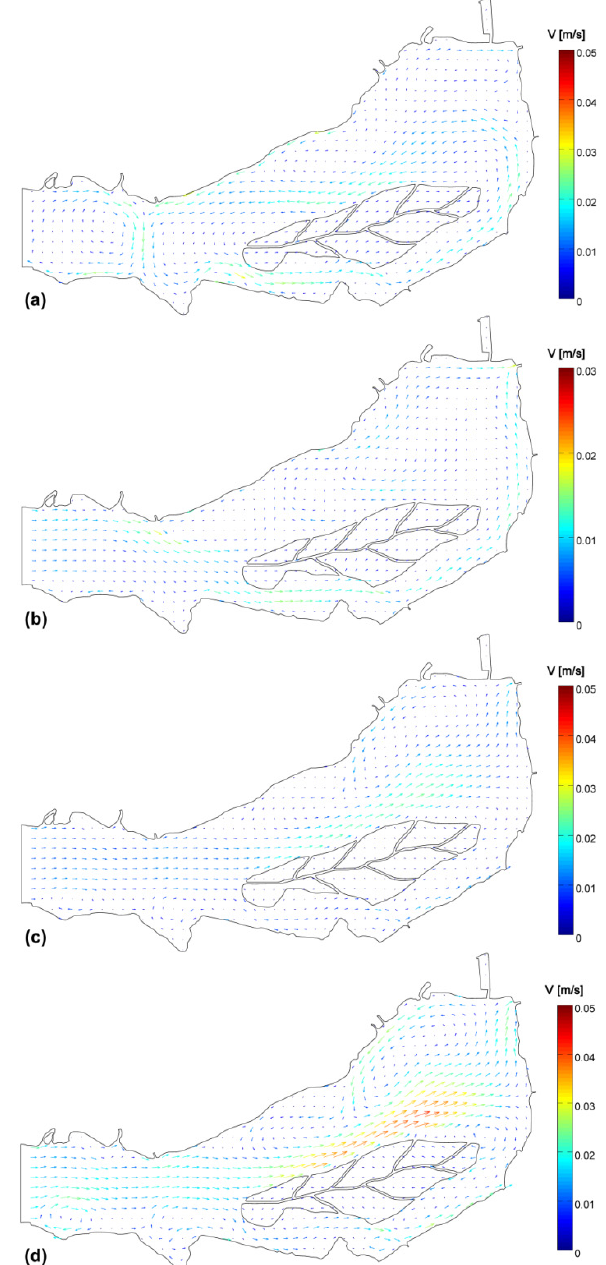
Figure 5. Surface 1 m depth-integrated flow fields for the MIVIS 26 July 2007 ( a ); CHRIS-PROBA 29 June 2008 ( b ); CHRIS-PROBA 28 August 2011 ( c ) and APEX 21 September 2011 ( d )